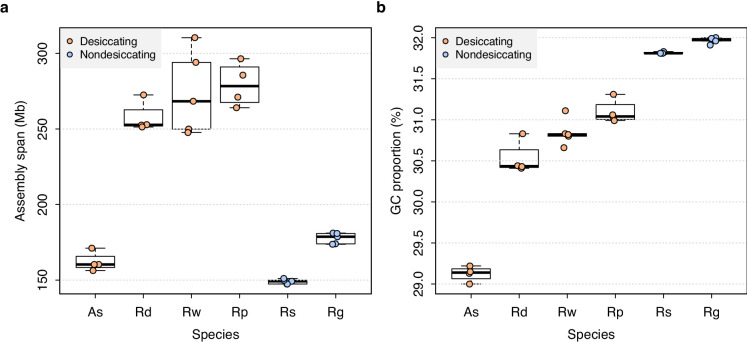
Genome characteristics for bdelloid samples.Boxplots are shown for (a) genome assembly span and (b) GC proportion (percent G + C nucleotides). Data shown for species with n ≥ 3 individuals. Boxplots show the median (band), interquartile range (box), and minimum/maximum values (whiskers). Underlying data are shown as jittered points.